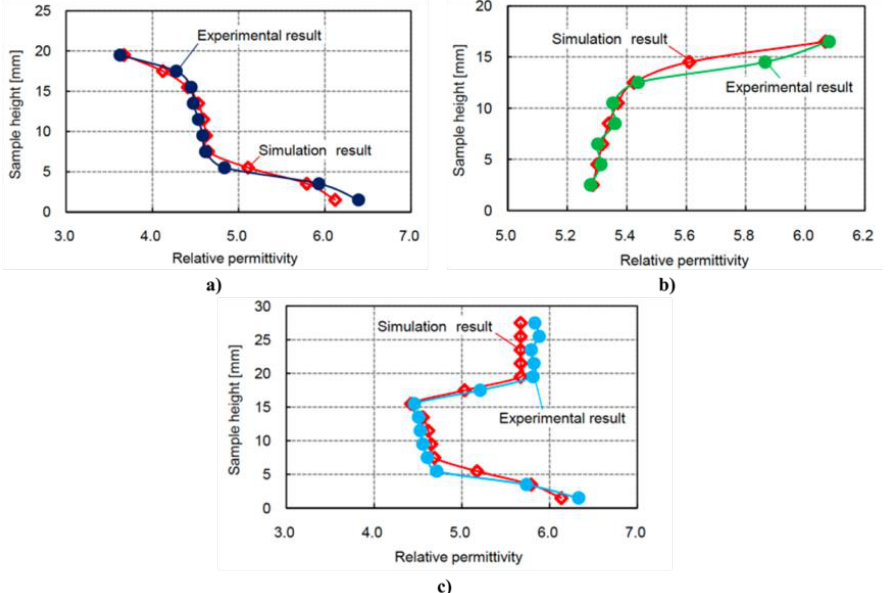
Figure 46. Experiments and simulation results of relative permittivity distributions in FGM: ( a ) GHP-FGM, ( b ) GLP-FGM, and ( c ) U-FGM. © 2021 IEEE. Reprinted, with permission, from [117].